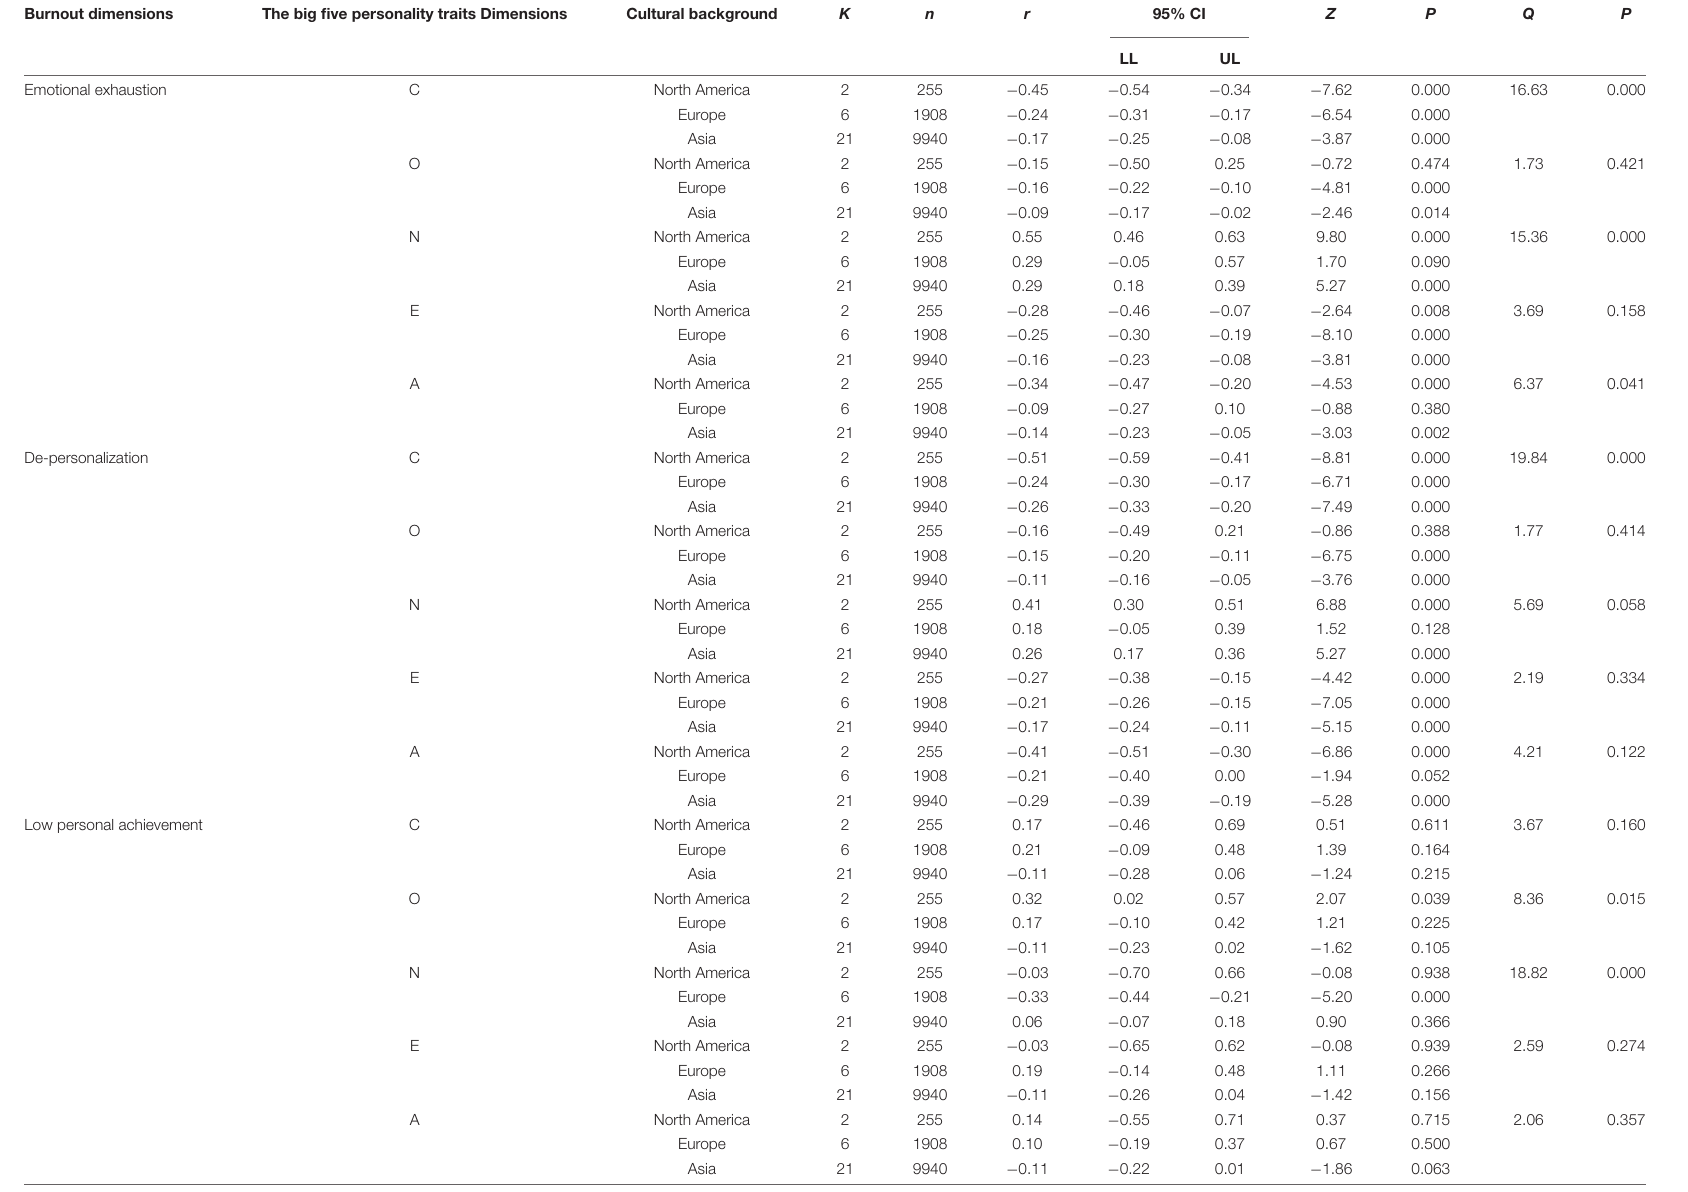
TABLE 6 | Regulatory effect of cultural background on the relationship between big five personality traits and job